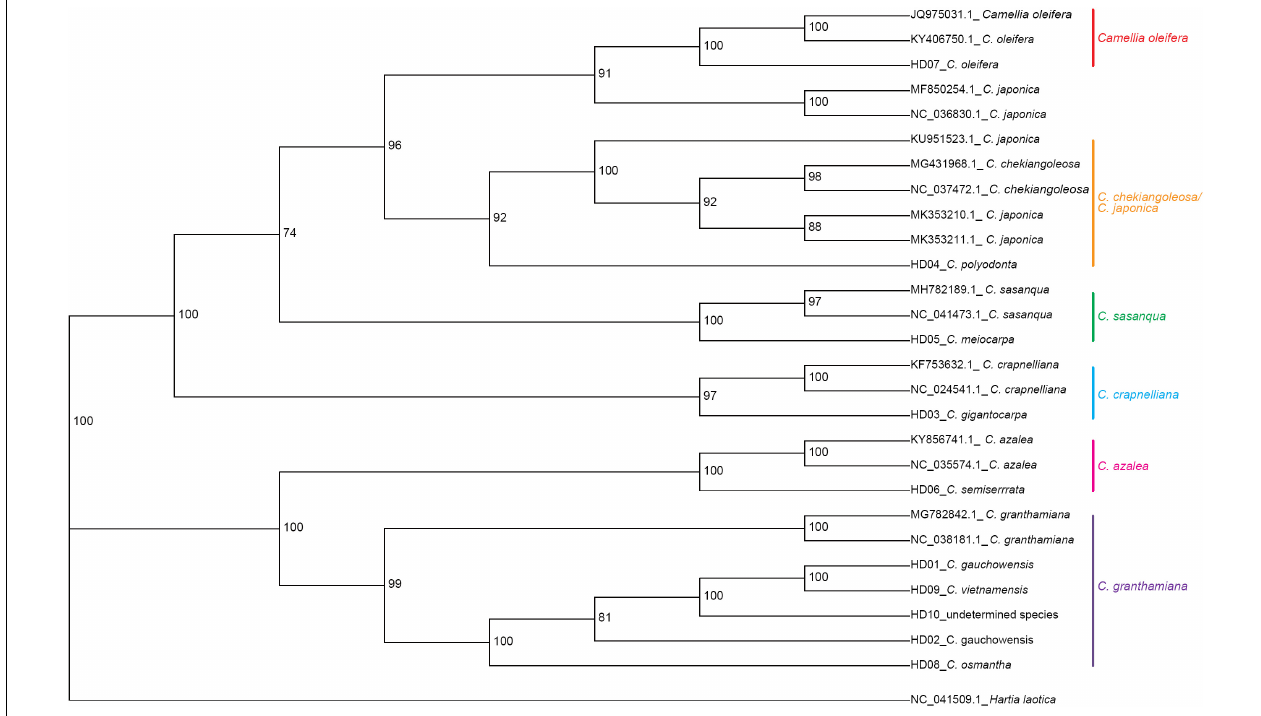
units, each oil-tea camellia species will differ from others in